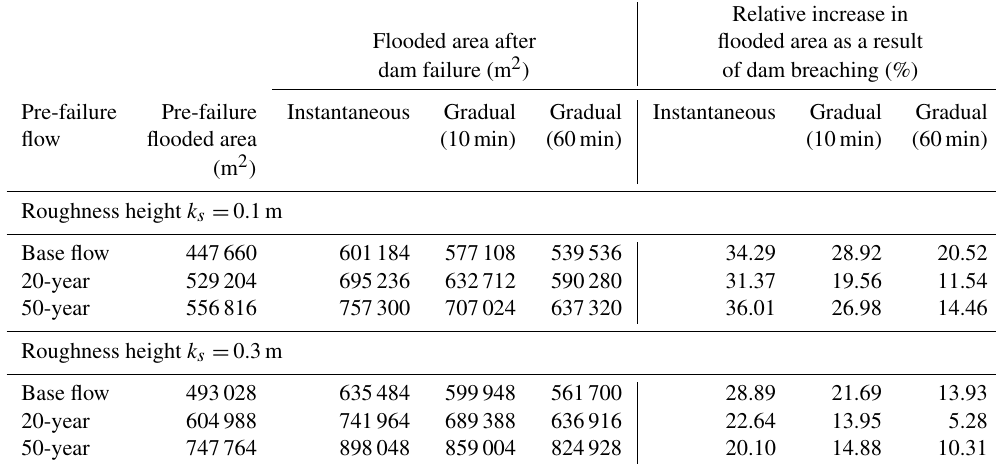
Table 10. Predicted changes in terms of flooded area due to the landslide-induced dam breaching for roughness are equal to 0.1 and 0.3m. Relative increase in Flooded area after flooded area as a result dam failure (m 2 ) of dam breaching (%) Pre-failure Pre-failure Instantaneous Gradual Gradual Instantaneous Gradual Gradual flow flooded area (10min) (60min) (10min) (60min) (m 2 ) Roughness height k s = 0.1m Base flow 447660